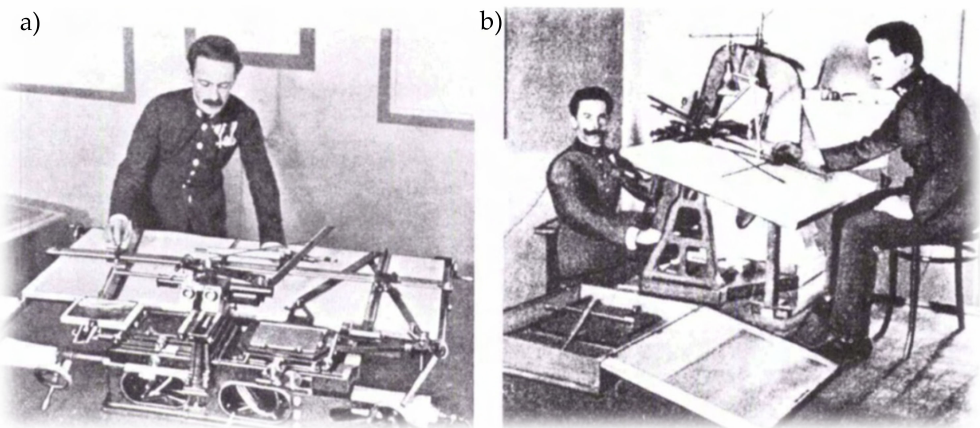
Figure 1. The first mechanical stereographs, developed in parallel by ( a ) Van Orel of Austria and ( b ) Vivian Thomson of England (Adapted from https://www.asprs.org/wp-content/uploads/pers/1985journal/jul/1985_jul_919-933.pdf, accessed on 18 October 2021), had a significant impact on cadastral mapping in later